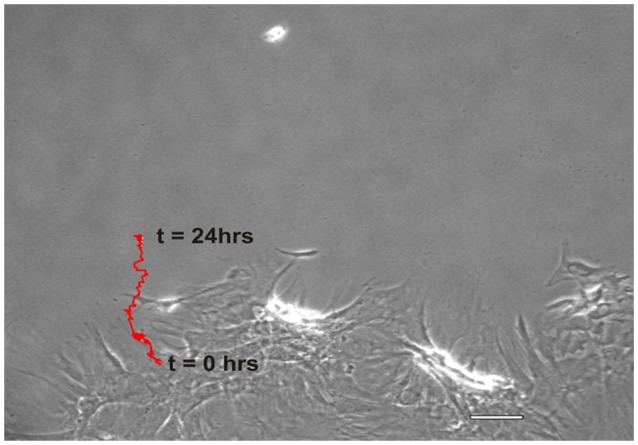
Representative migration path of a MSC from the wound margin into the open wound area over a period of 24 h, t = 0 to t = 24 h. The red trace distance was the total length and shape of the migration path, i.e., the course typically taken by an individual MSC. (Scale bar = 100 μm).